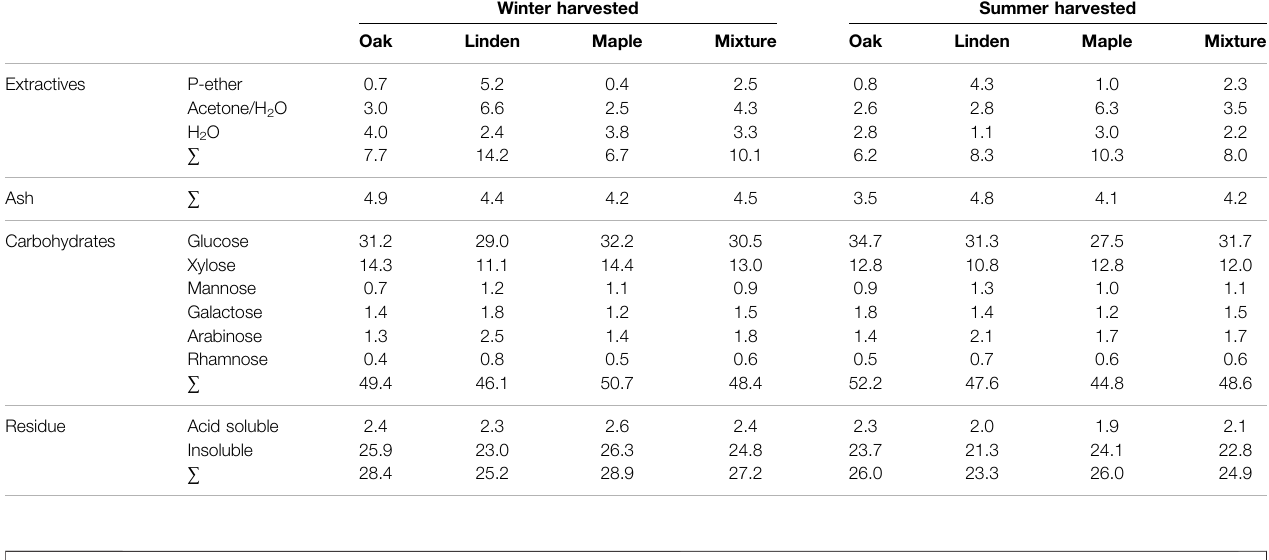
TABLE 2 | Content of extractives, ash, carbohydrates, and acid hydrolysis residue of tree pruning material harvested in winter and summer (% based on raw material). Winter harvested